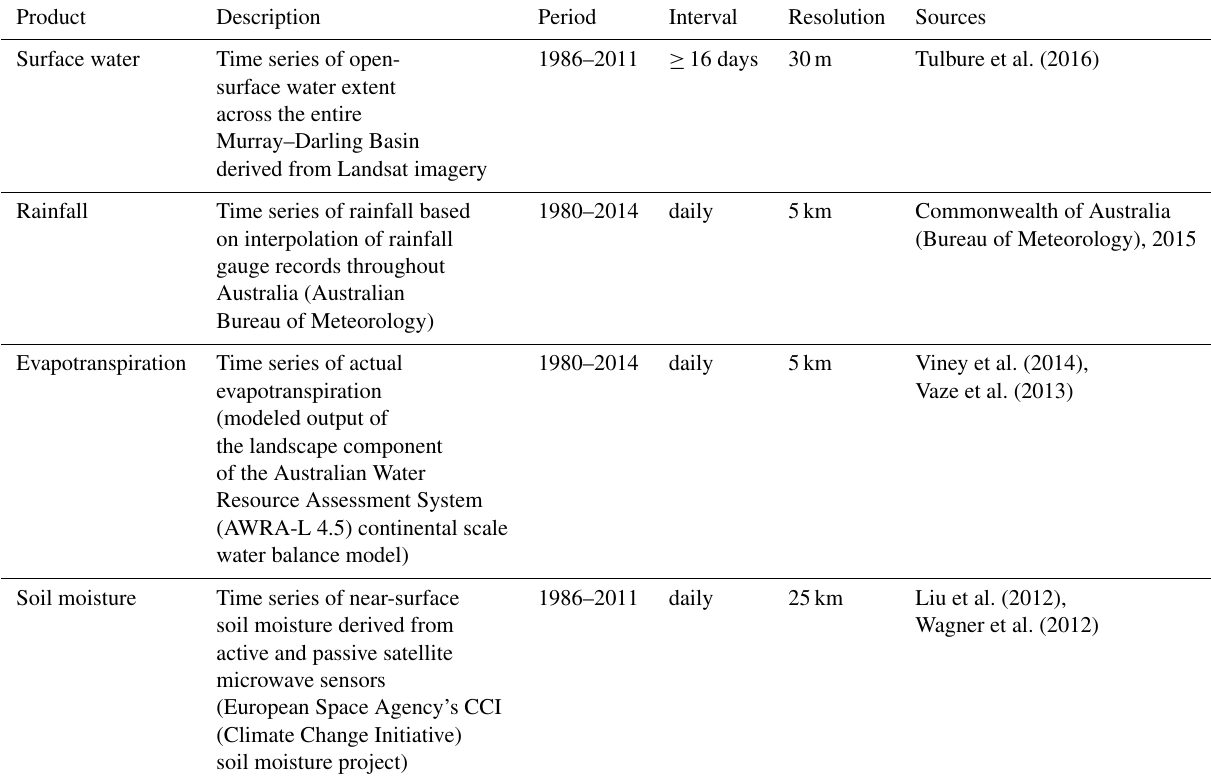
Table 2. Overview of spatial time series used for modeling SWE dynamics.